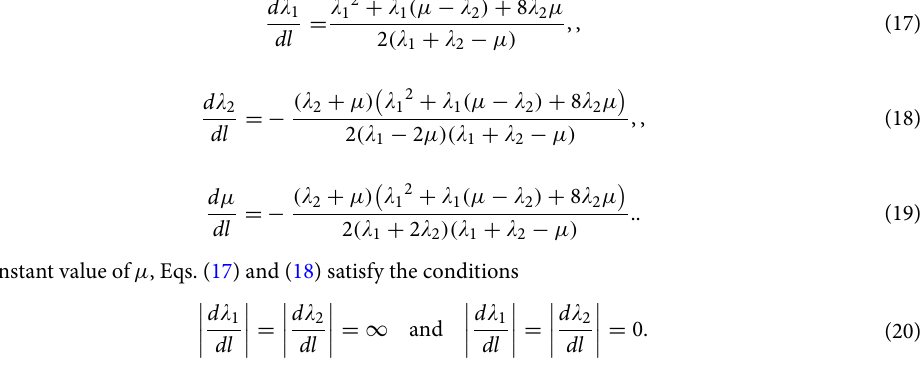
(cid:31) 1 ( (cid:31) 1 µ) (cid:31) (cid:31) µ One can observe critical line and fixed line respectively at (cid:31) 2 + 1 and 2 = (cid:31) 1 8 µ . RG flow lines for the = − − 0 . It consists of two figures for different values of coupling parameters (cid:31) 1 and (cid:31) 2 are depicted in Fig. 6 for k 0 = µ . In each figure the quantum critical line and fixed line are represented as solid and dashed lines respectively. Direction of the RG flow, in the (cid:31) 1 - (cid:31) 2 plane, is shown by the arrows, which signals the presence of critical and (cid:31) µ fixed lines. The critical line is denoted by solid line in the flow diagram which traces a line (cid:31) 2 1 as pre- = − 0 and w 1 gapped phases for (cid:31) 1 < 2 µ and w 2 and dicted analytically. This line distinguish between, w = = = 1 gapped phases for (cid:31) 1 > 2 µ for µ 0 . The RG flow of coupling parameters (cid:31) 1 and (cid:31) 2 flows away from the w = = 0 critical line and towards the stable fixed line as shown in Fig. 6a,b. One can dubiously distinguish between w = 2 gapped phases based on the flow lines, which flows towards (cid:31) 1 2 phase and towards the 2 µ in w and w = = = 0 phase. fixed line in w = Multi-critical point appear exactly at the intersection of critical and fixed lines, i.e at the point ( (cid:31) 1 , (cid:31) 2 ) ( 2 µ , µ) . This intersection point can be obtained analytically by equating critical and fixed line = − 4 µ (cid:31) 1 4 µ 2 0 . The solution of this quadratic equation is equations, which yield a quadratic equation (cid:31) 2 1 − + = (cid:31) 1 = 2 µ which is the multi-critical point for the HSP k 0 = 0 . The curvature function is found to be diverging at this point. This multi-critical point distinguish the critical phases (cid:31) 1 < 2 µ and (cid:31) 1 > 2 µ on the critical line, whose physics can also be captured by the CRG method which is discussed in the next section. In order to show the distinct nature of CP-1 and CP-2, we calculate the critical exponents, explained in Eq. (13), and characterize their universality classes. Set of critical exponents ( z , ν , γ) characterize the critical phases 0 and w 1 as well as w 2 and w 1 gapped phases. To calculate which governs the transition between w = = = = 0 these critical exponents we first expand the Hamiltonian terms χ z and χ y from Eq. (3), around the HSP k 0 =